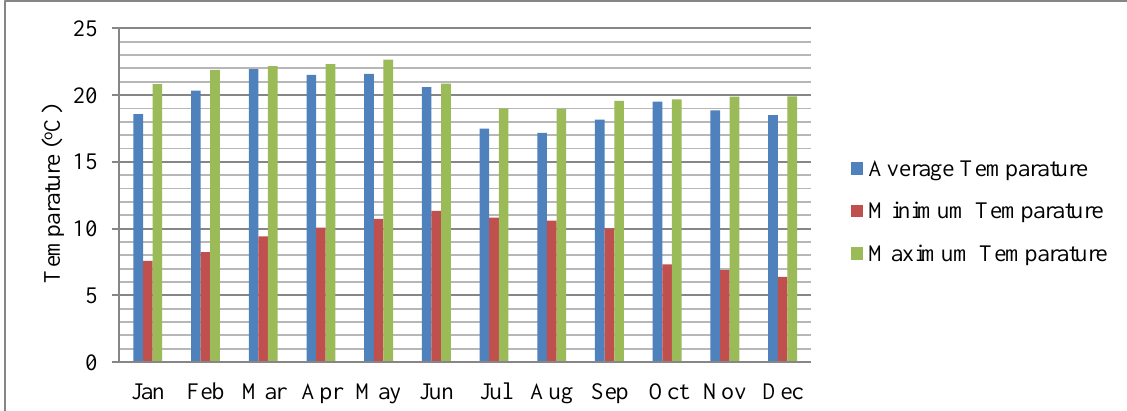
Figure 2. Temperature data assessment of Debre Berhan in the North Shewa zone.